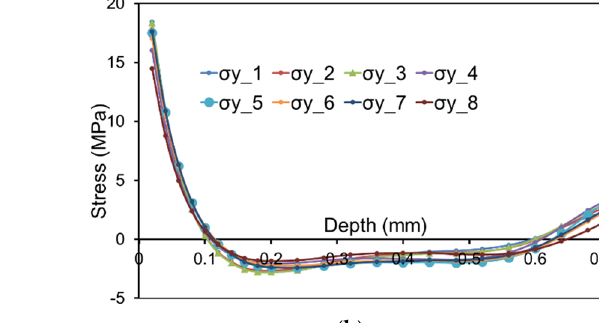
( c ) Figure 15. Removal of the stain gauge rosette foil for precisely determining the surface of the sample via stepwise drilling. The following steps are highlighted: ( a ) before drilling, ( b ) intermediate stage (very thin foil film remained) and ( c ) the first view of the surface of the sample. To achieve the aim of studying the effect of the choice of a non-exact depth setting on the resulting residual stresses, a series of non-adequate depth settings having different deviations from the ideal depth position were considered to evaluate the residual stresses; see Figure 16 for the results. Note that the label (0 μ m) indicates the optimal zero-depth setting, while the other labels (30 μ m and 60 μ m) imply that the adopted zero-depth set- tings are 30 and 60 μ m beneath the surface of the sample, respectively. Based on the results shown in Figure 16, it can be clearly seen that the consequences of an incorrectly assumed